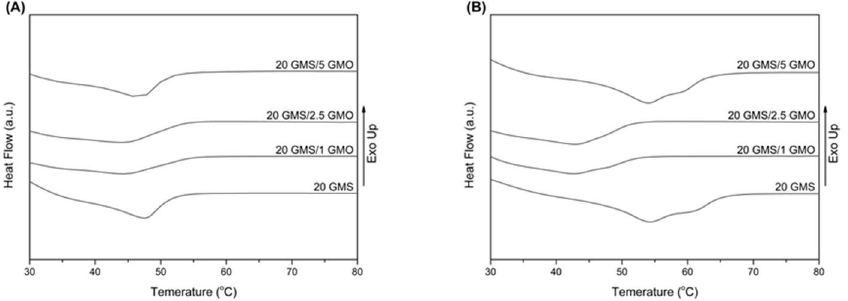
Figure 4. DSC thermograms of heating curves for the different formulations: ( A ) 0 h stored at 4 °C and ( B ) 24 h stored at 4 °C (heating rate 10 °C/min).